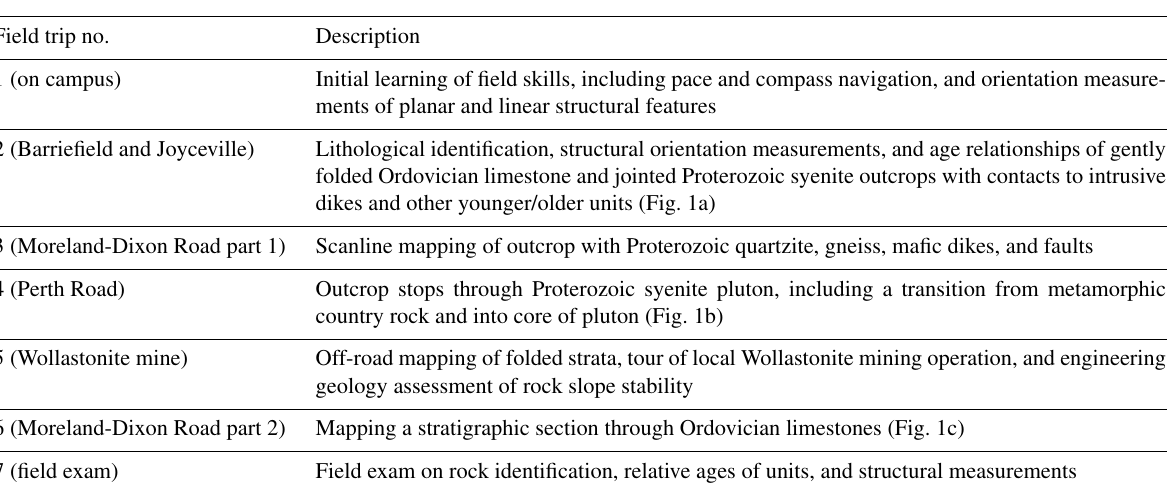
Table 2. In-person field trips for GEOE/L 221 in fall 2019. Field trip